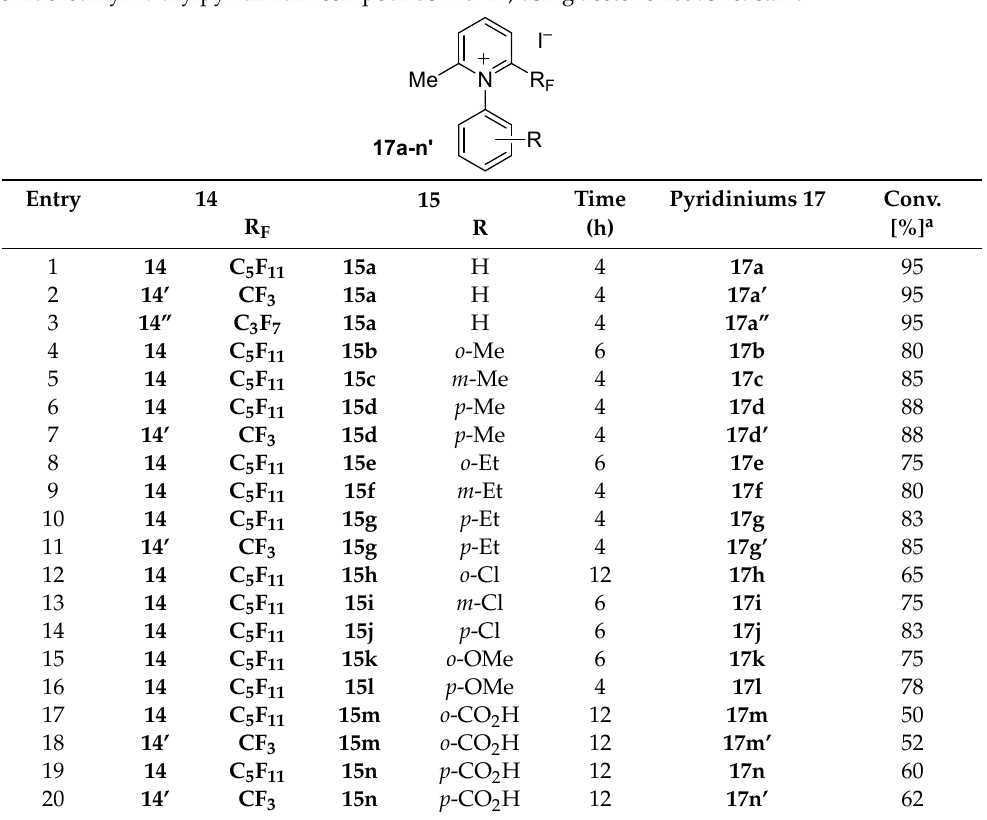
Table 1. Reaction conditions and conversions for the synthesis of substituted 2-trifluoromethyl-/2- perfluoroalkyl- N -arylpyridinium compounds 17a – n’ , using acetone 16t as reactant.